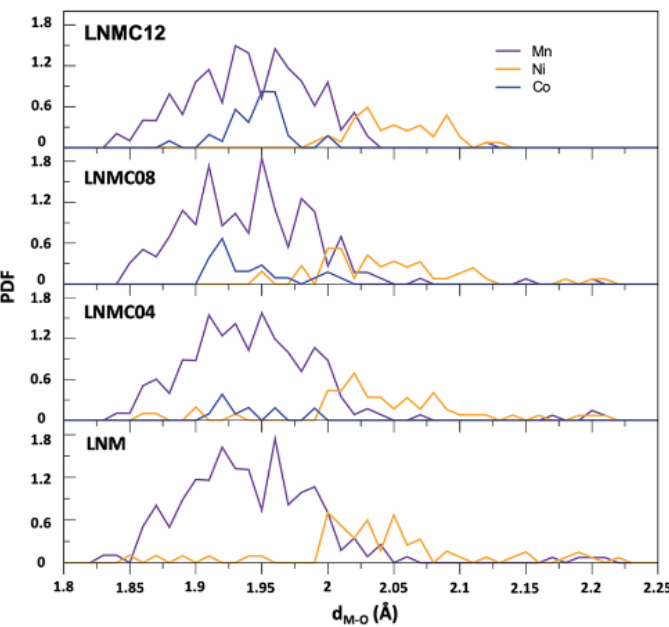
Figure 3. Pair Distribution Functions (PDFs) of LNMC12 (upper panel), LNMC08 (middle panel), LNMC04 (middle panel), and LNM (bottom panel) for Mn-O, Ni-O, and Co-O bond distances.